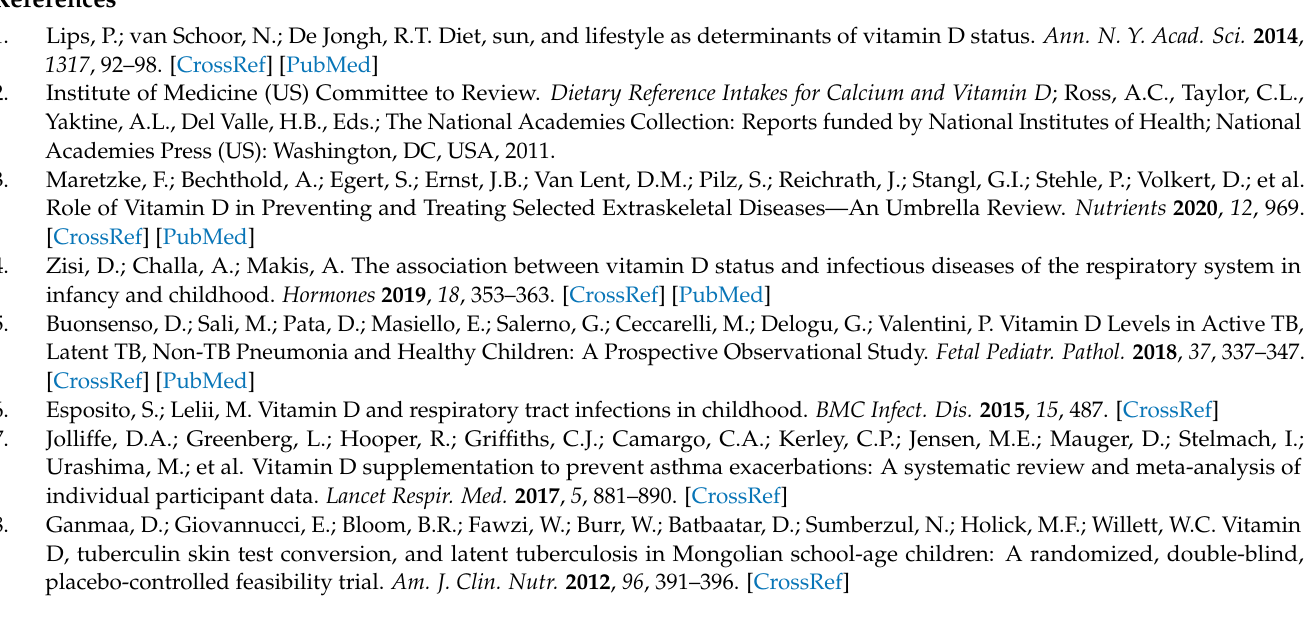
Table S2: Multivariate logistic regression model of determinants of 25(OH)D deficiency (25[OH]D <50 nmol/L), excluding BMI-for-age Z-score